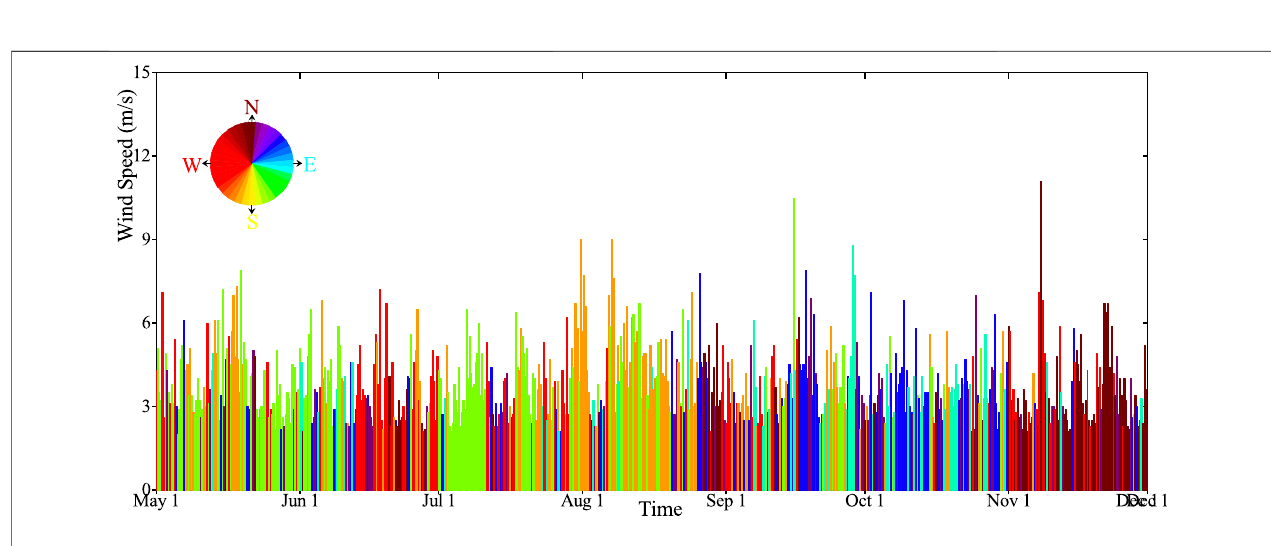
FIGURE4| Regional distribution ofvegetation intheTaihu Lakearea. P1 – P4are theobservation points, and D1 istheobservation section ofnumericalsimulation.